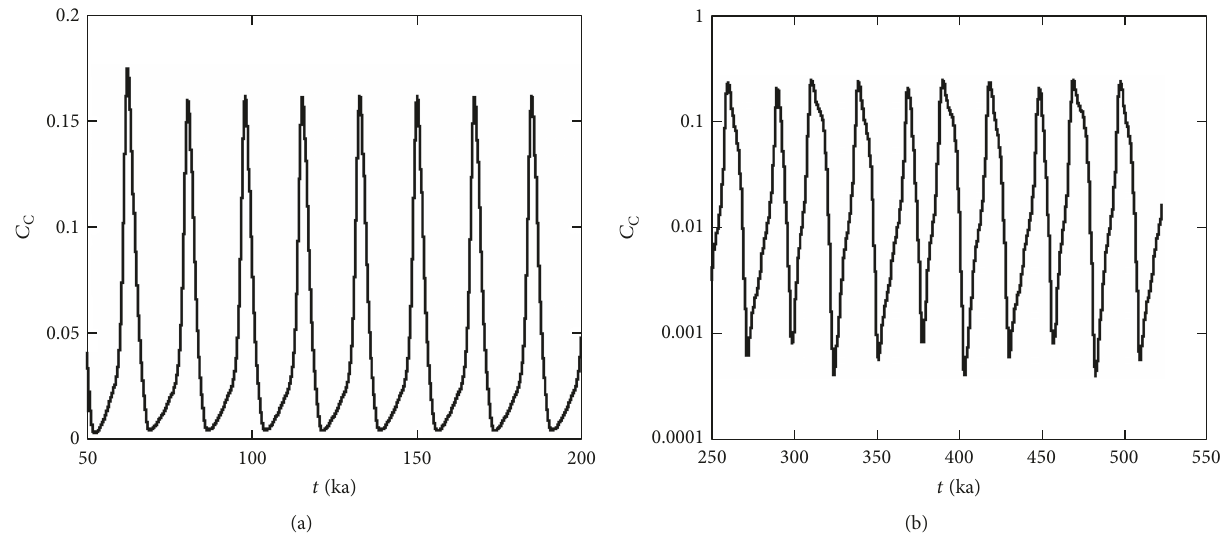
Figure 4: Numerical solutions for scenario A illustrating self-organized oscillations. The calcite composition at the bottom of the system ( 𝑥 = 𝐿 ) is plotted as a function of time. (a) 𝜙 in = 𝜙 0 = 0.8. Oscillation period = 17,290 a. (b) Complex oscillation obtained with 𝜙 in = 0.8 and 𝜙 0 = 0.74. Average time between troughs = 26,288 a.